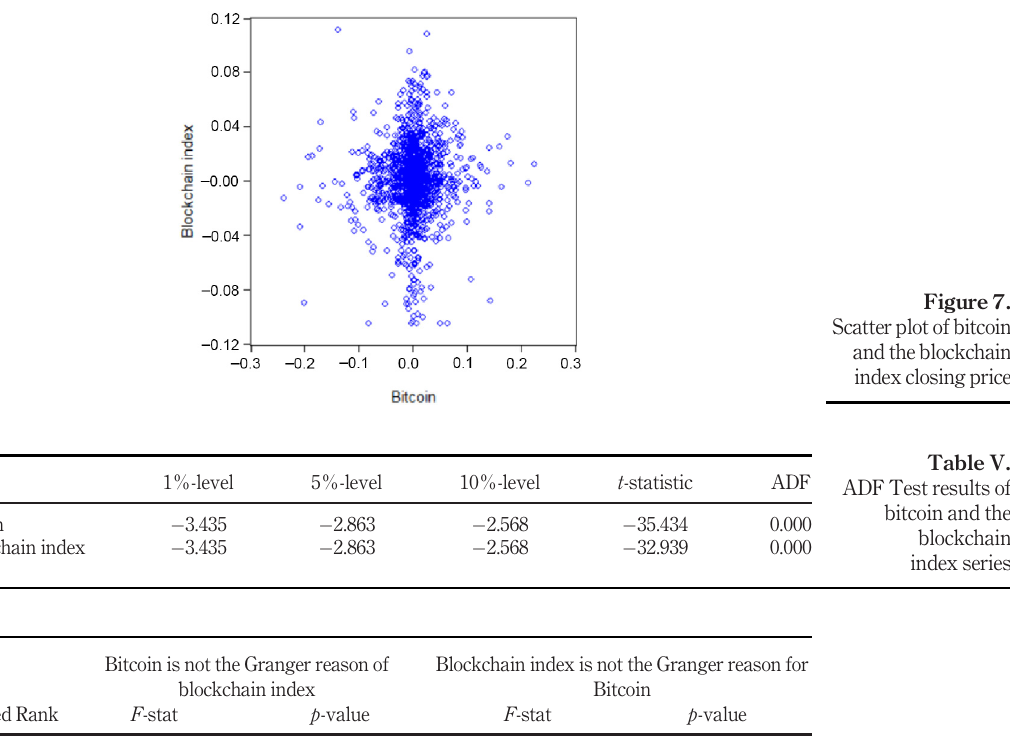
Table VI. Granger